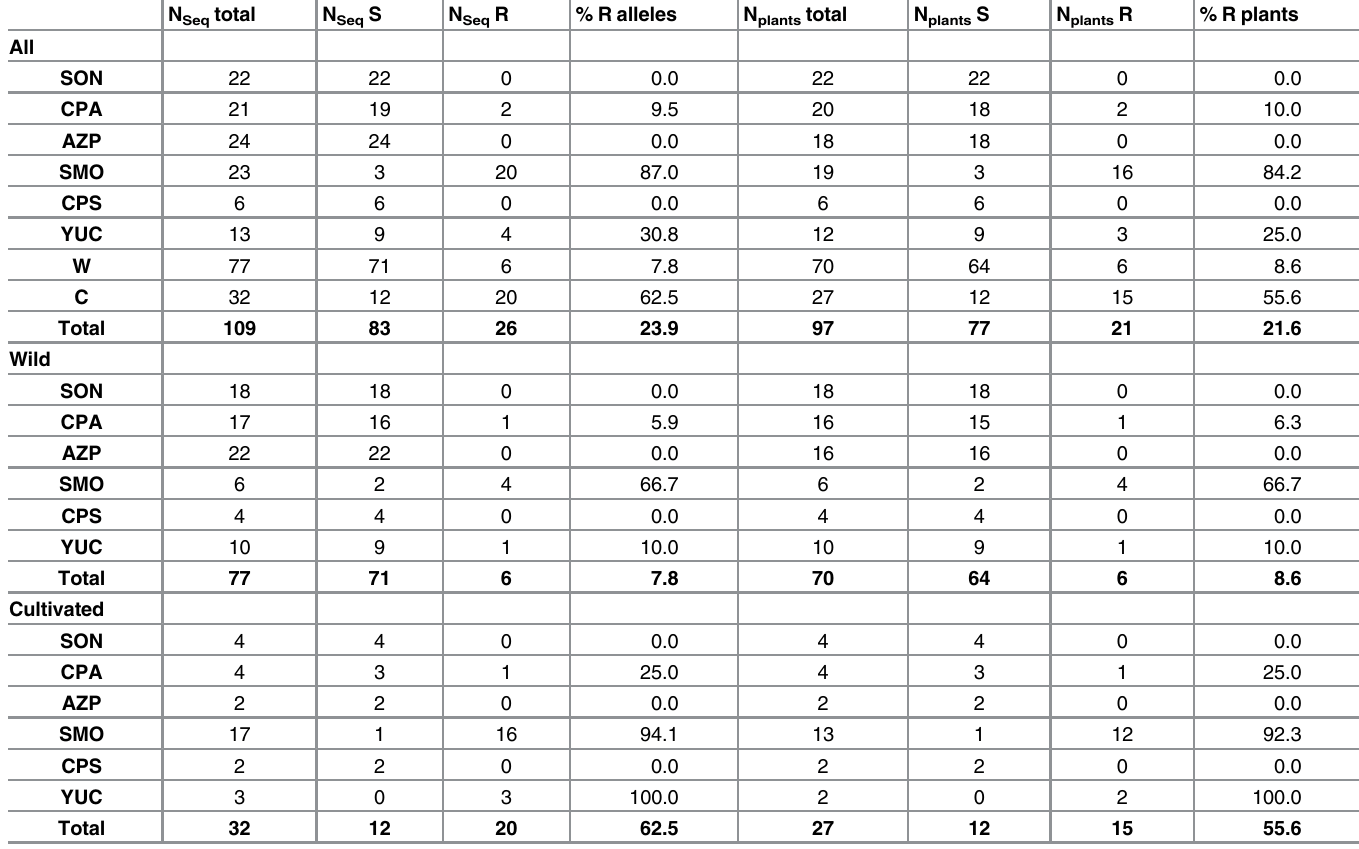
Table 3. Frequency of potyvirus resistance alleles and resistant plants according to biogeographical province and habitat. N Seq total N Seq S N Seq R % R